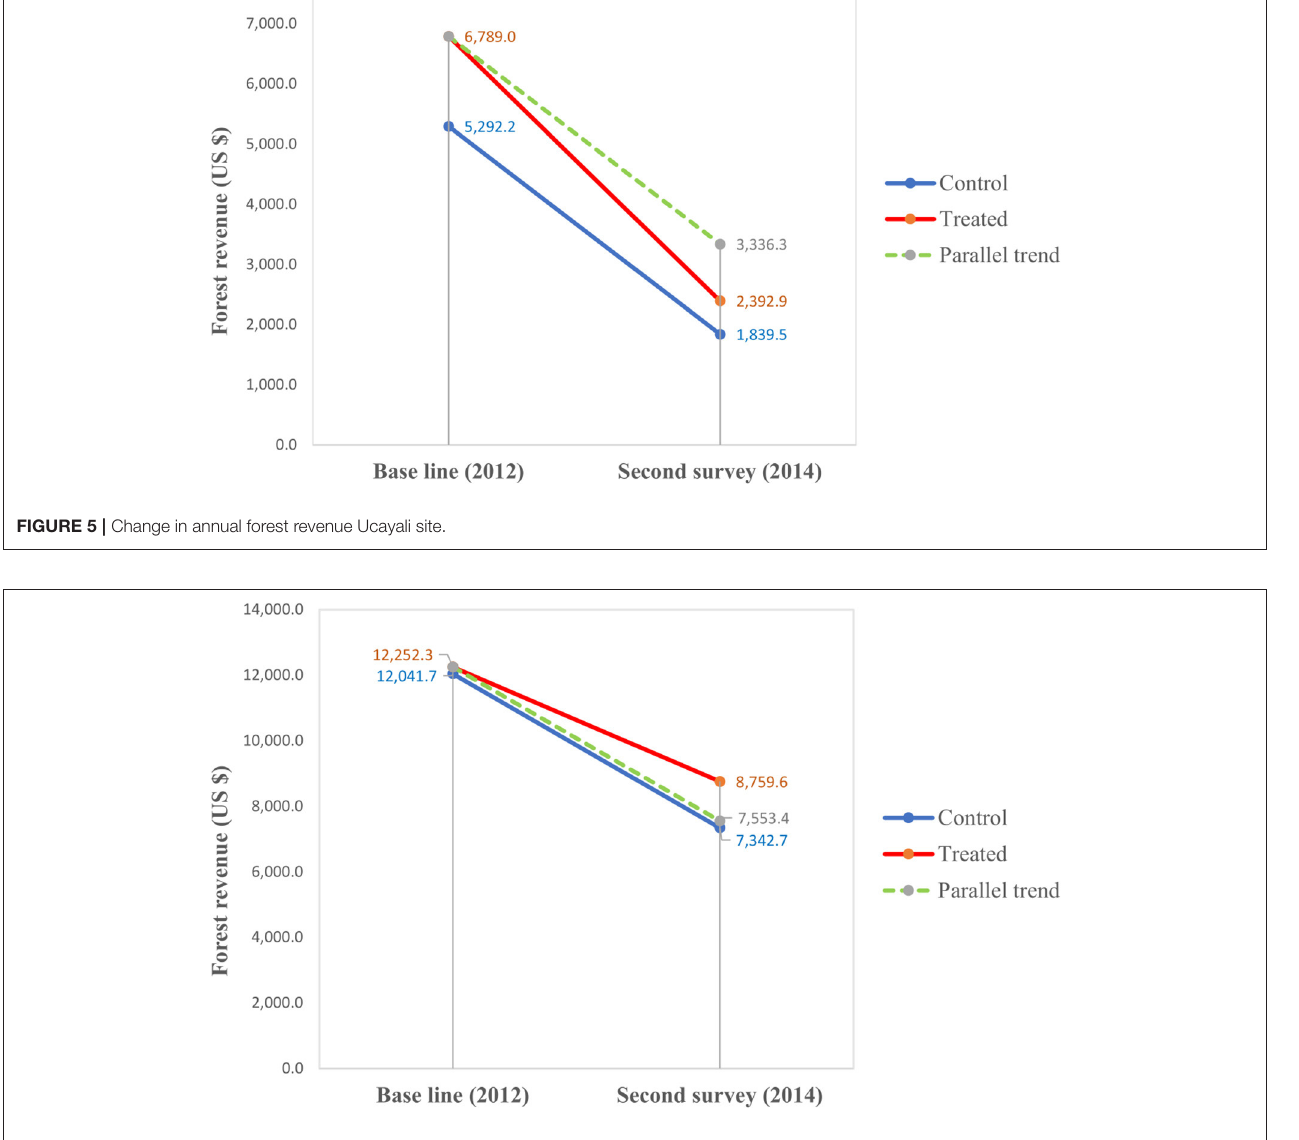
FIGURE 6 | Change in annual forest revenue Madre de Dios